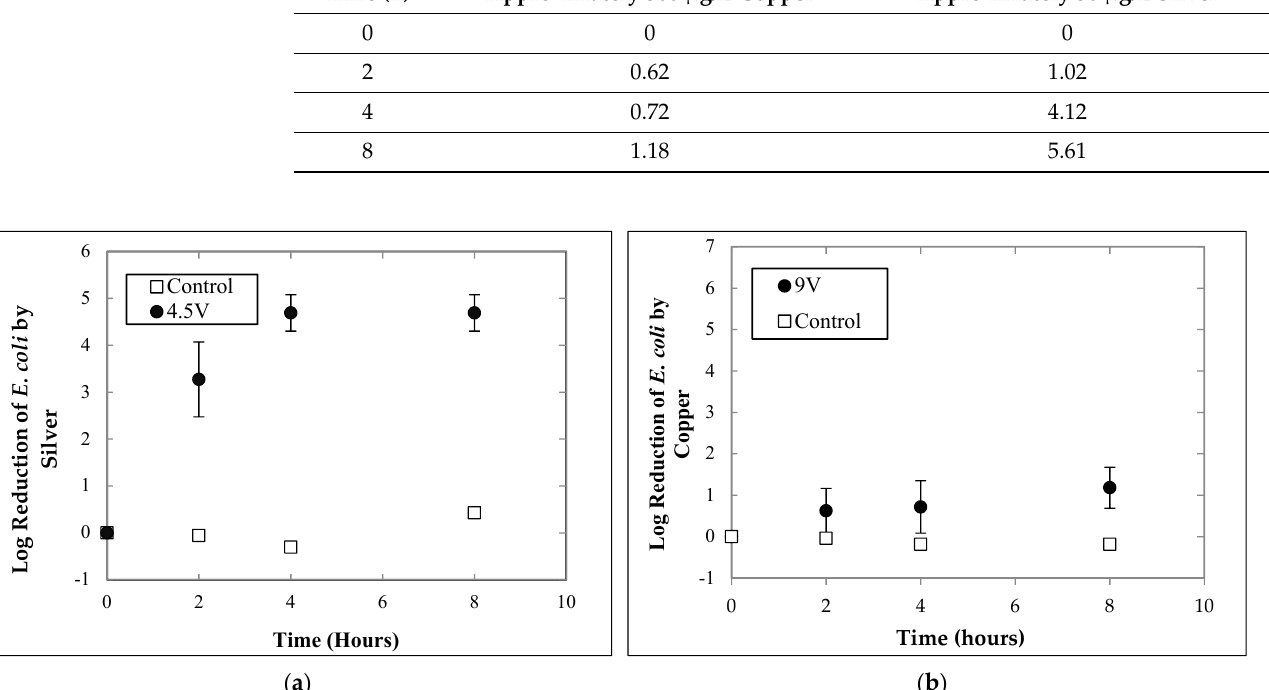
Log Reduction in E. coli